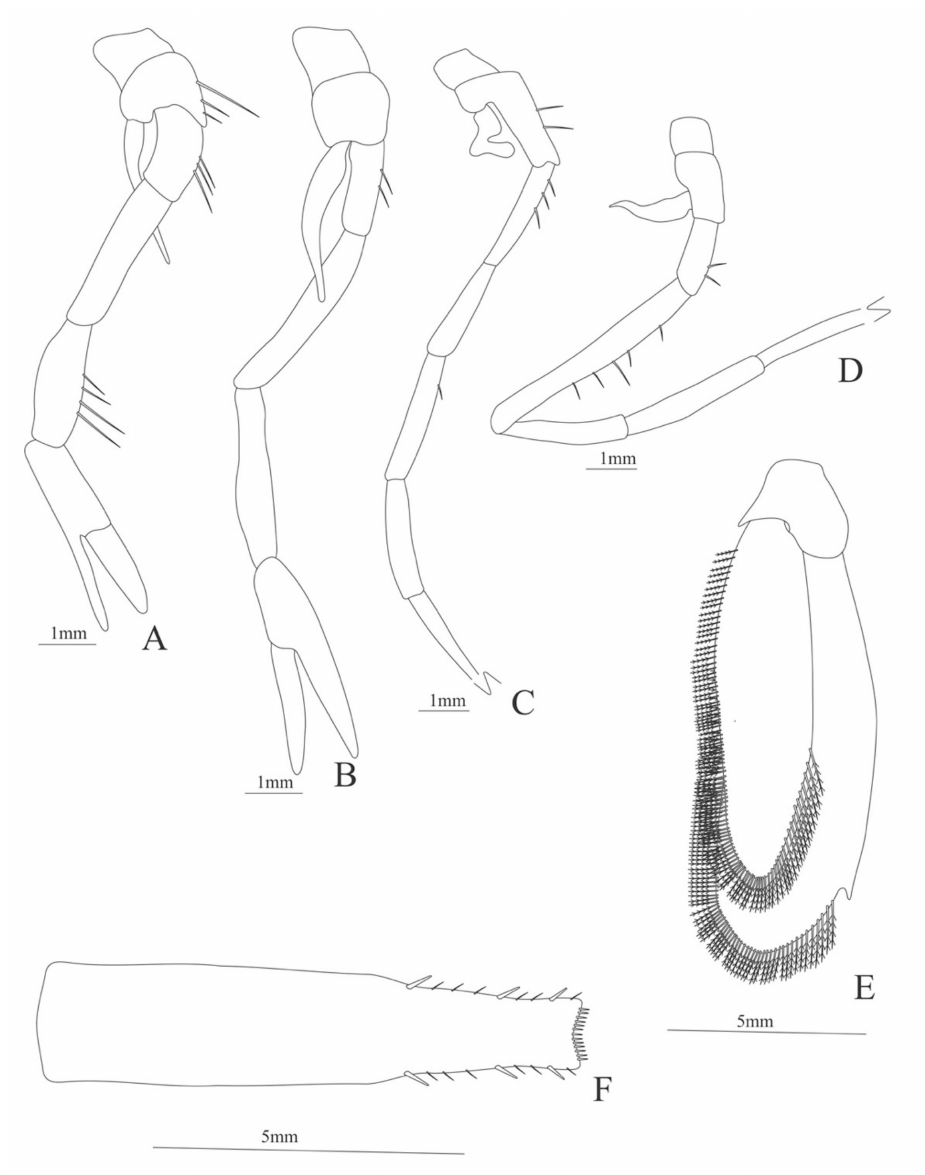
Figure 30. Cerataspis monstrosus : ( A ) second pereopod; ( B ) third pereopod; ( C ) fourth pereopod; ( D ) fifth pereopod; ( E ) uropods; ( F ) telson. Carapace (Figure 31A) with rostrum short, armed with 5–7 dorsal spines, epigastric tooth